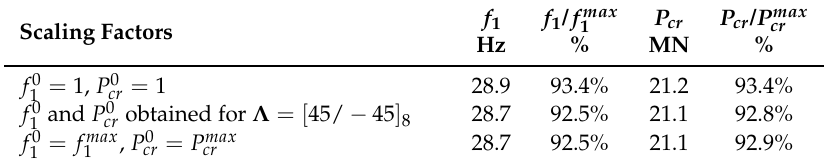
Table 3. Nadir points selected as the ones maximizing the relative values of f 1 and P cr . Scaling